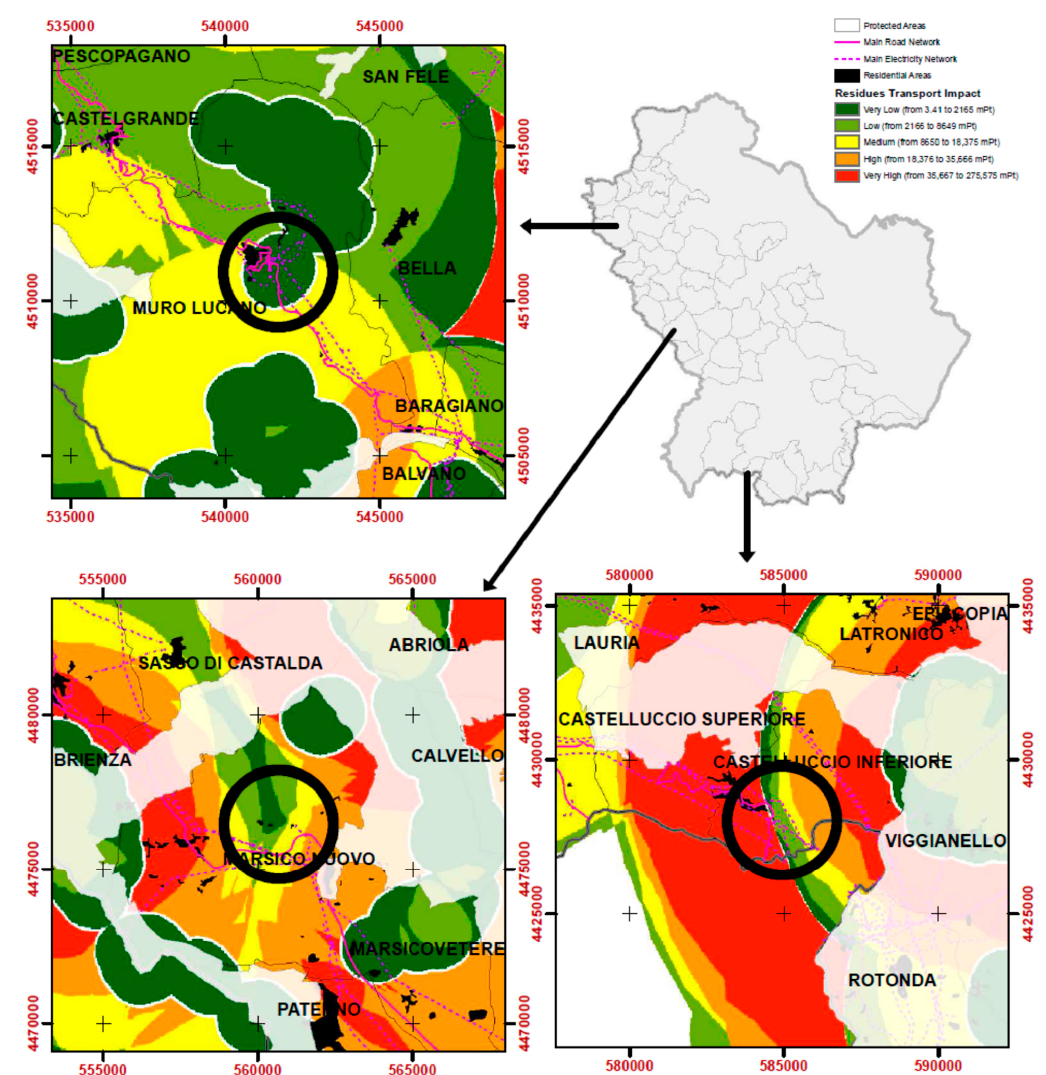
Figure 4. The three sites suitable for biomass power plant construction * .